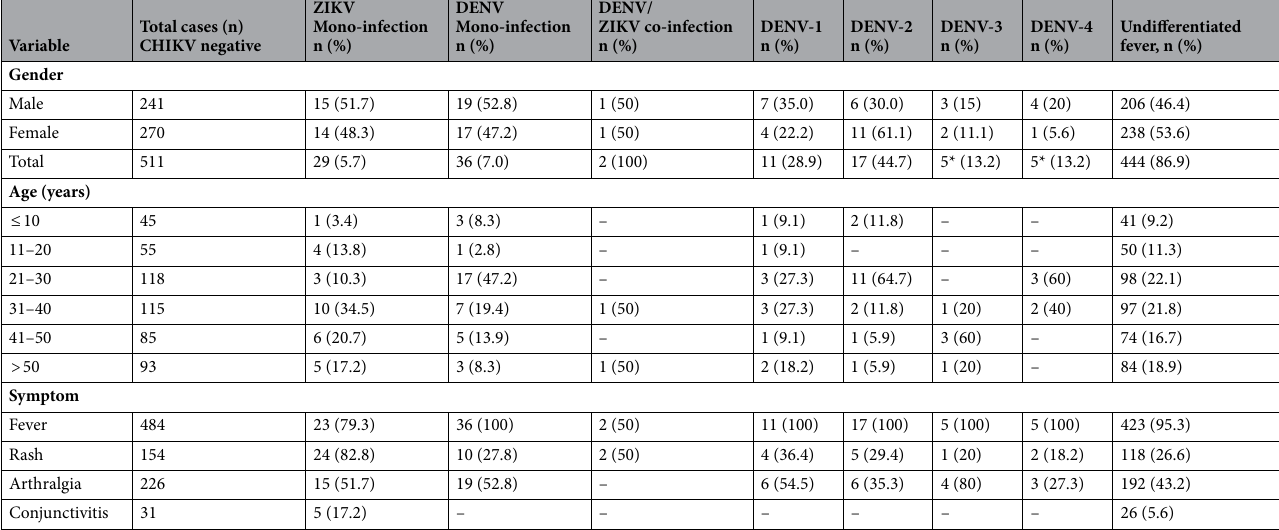
Table 1. Demographic and clinical presentation of ZIKV and DENV cases confirmed by RT-PCR screening of CHIKV-negative sample (n = 511). *One case involved DENV and ZIKV